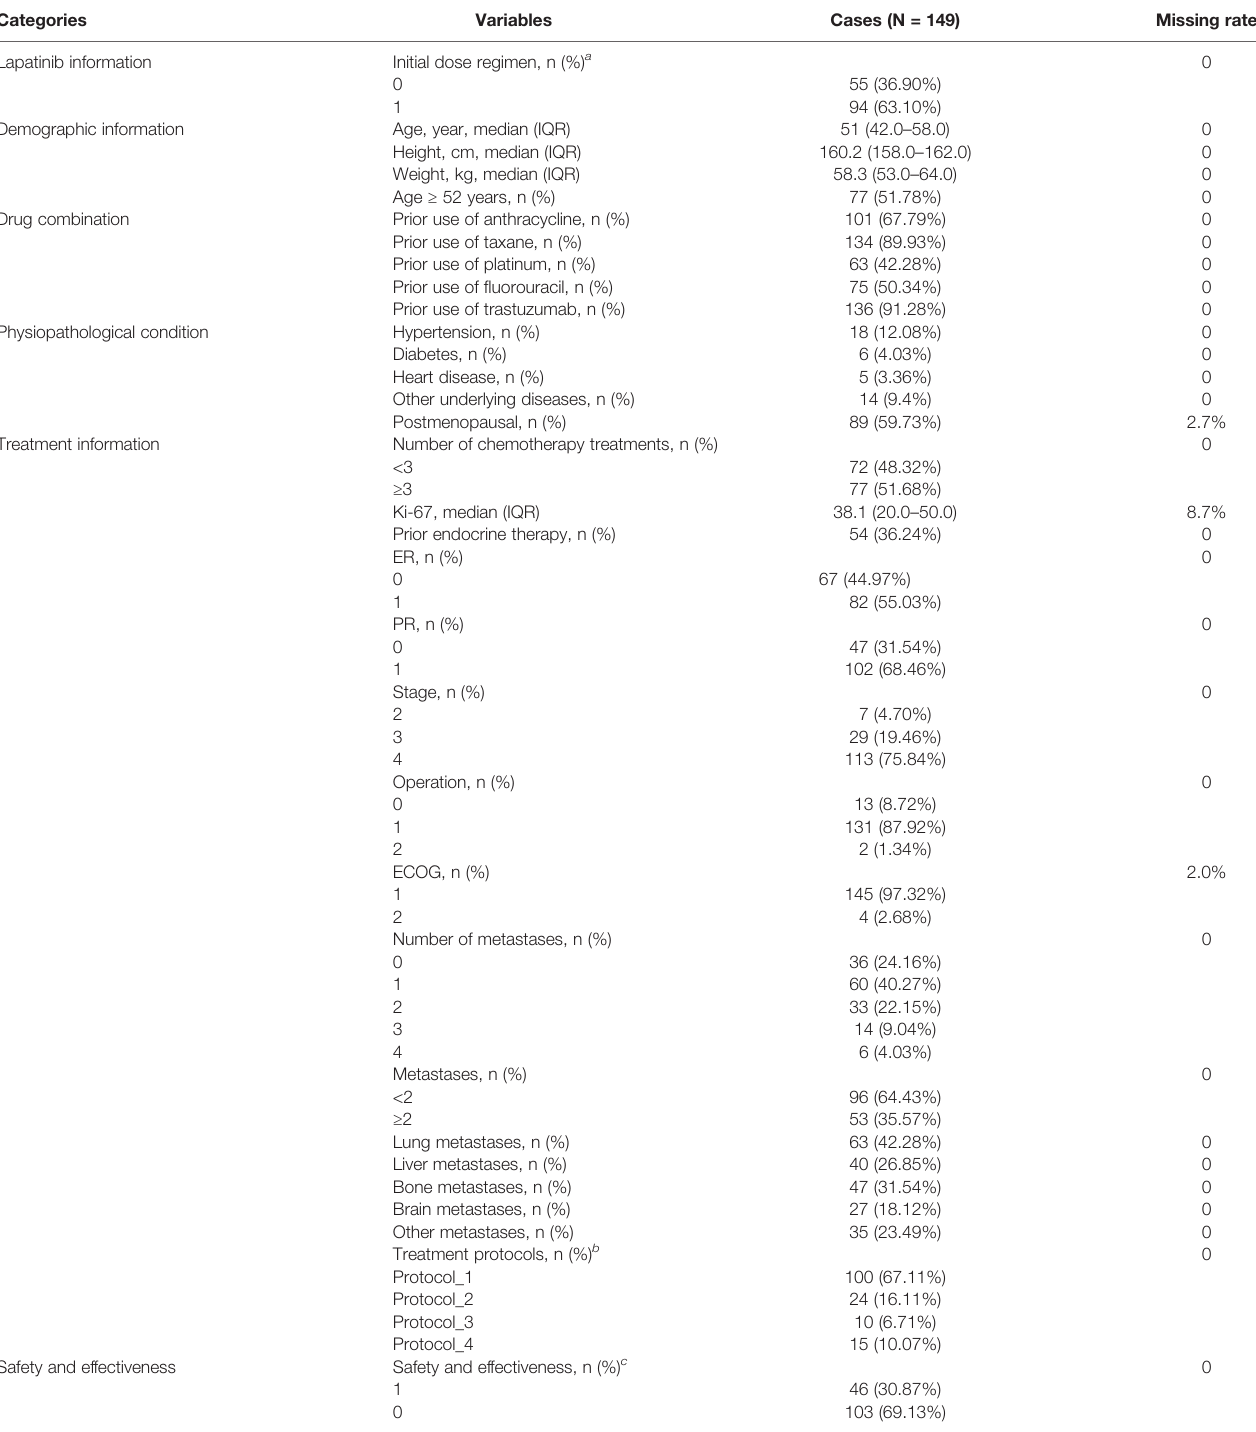
TABLE 3 | Description of demographic and clinical